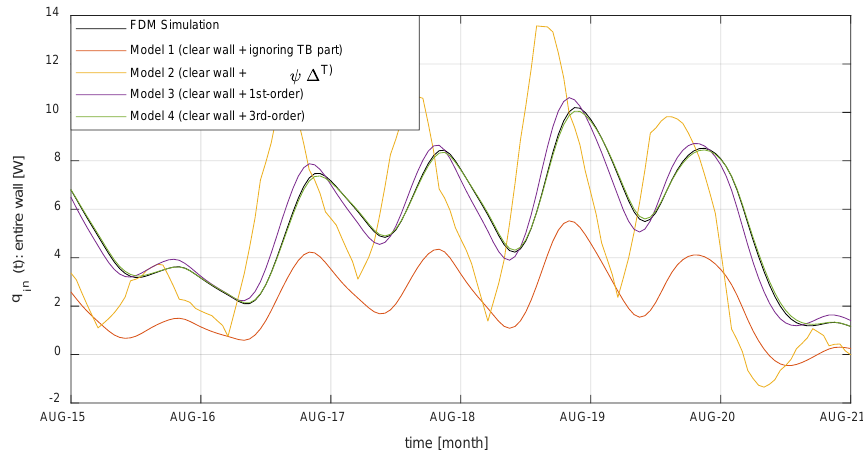
Figure 14. Heat flow through the entire wall (Summer).